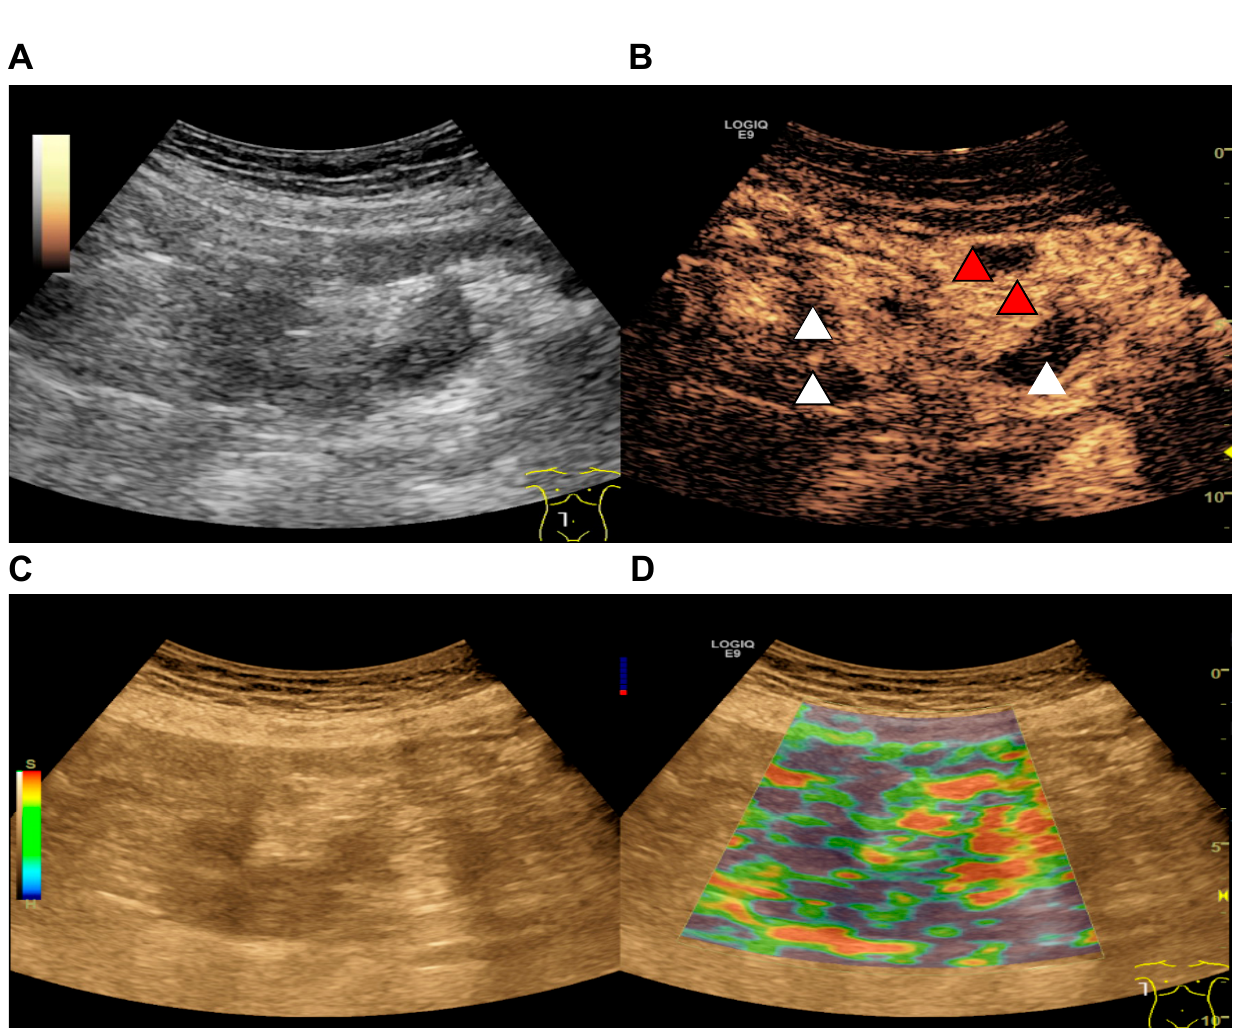
Figure 1. Ultrasound images of a patient with histological confirmation of acute intestinal GvHD. A + C : B-mode ultrasound showing intestinal wall thickening. B : CEUS image showing early arterial hyperenhancement of the intestinal wall (red arrows) and transmural penetration of microbubbles (white arrows). D : Soft tissue edema as a correlate of acute inflammation examined by strain elastography.